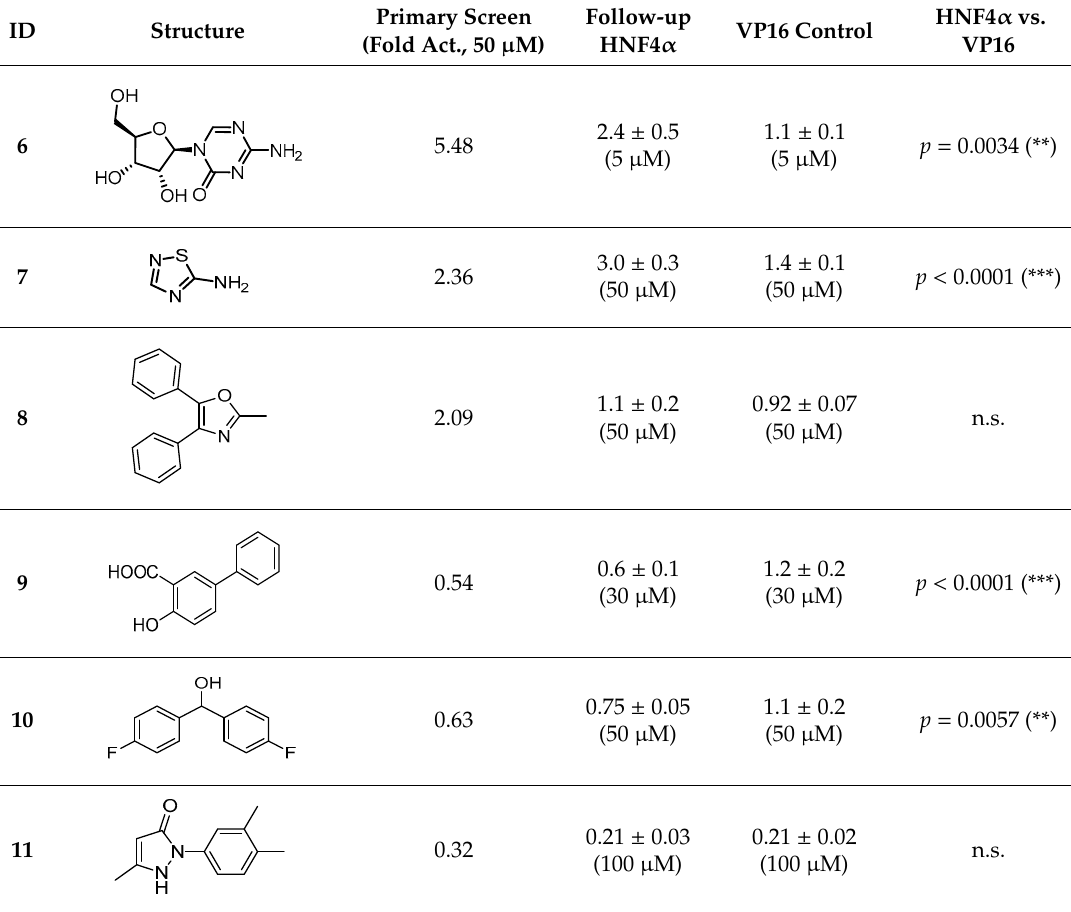
Table 2. Validated HNF4 α ligands with control experiment HNF4 α modulatory activity and binding affinity to the recombinant HNF4 α ligand-binding domain (LBD). EC 50 and IC 50 values were calculated from dose–response curves and are the mean ± SD of at least four biologically independent repeats in duplicates. Fold and remaining (rem.) activation (act.) refer to the maximum fold increase or decrease in reporter activity relative to 0.1% DMSO. Binding was determined by isothermal titration calorimetry (ITC). n.d. – not determined